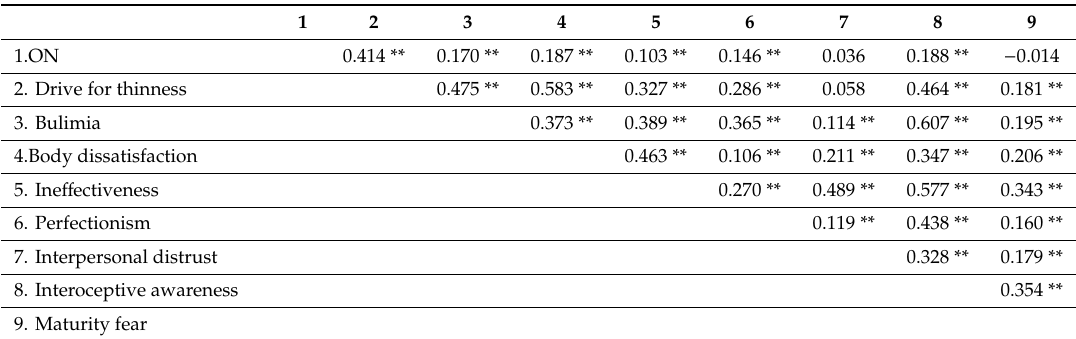
Table 5. Correlation between ON and ED symptoms in the total